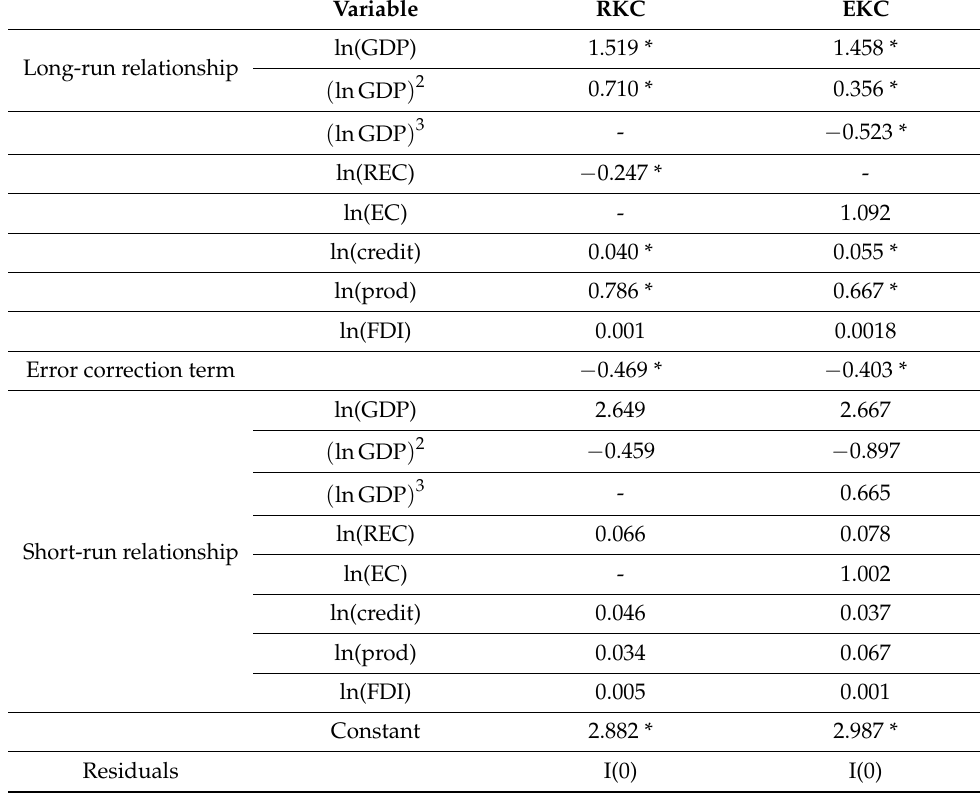
Table 10. Pool mean groups regressions to explain the GHG emissions in V4 countries, Bulgaria and Romania (EKC and RKC). Variable RKC EKC Long-run relationship